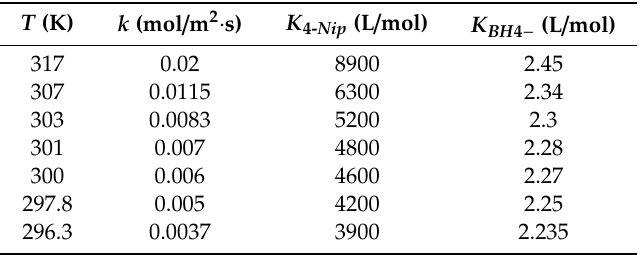
Table 3. The result of the rate constant k and the adsorption constants K 4- Nip and K BH 4 − at di ff erent temperatures from fitting the experimental Data with the Langmuir–Hinshelwood model.